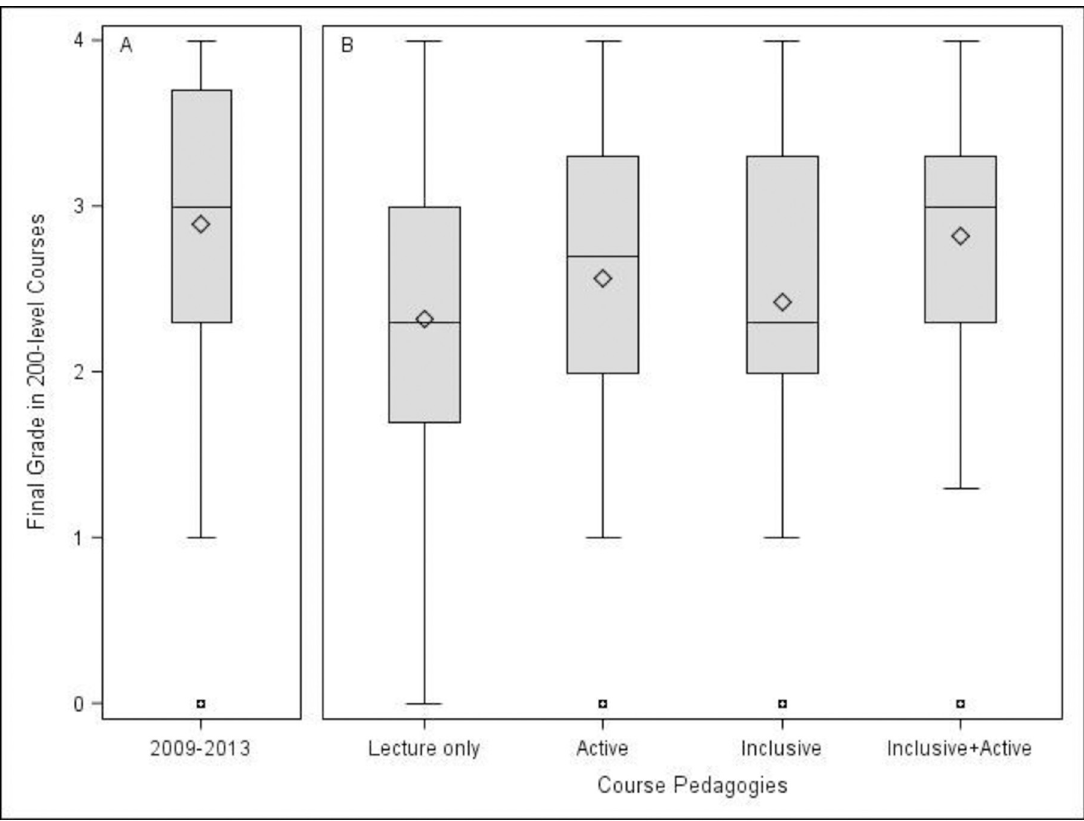
Fig 2. There was no difference between treatments and mean final course grades in 200-level biology courses over 2014–2018 (F(3, 239) = 2.17, p = 0.092, R 2 = 0.027, 95% CI [-0.013, 0.067]). Although data suggests there may be a small difference between the group who took the active and inclusive section both semesters (N = 23, M = 3.030, SD = 0.657) and the group who took them neither semester (N = 128, M = 2.541, SD = 0.907), F(1, 149) = 6.12, p = 0.015, R 2 = 0.039, 95% CI [-0.021,